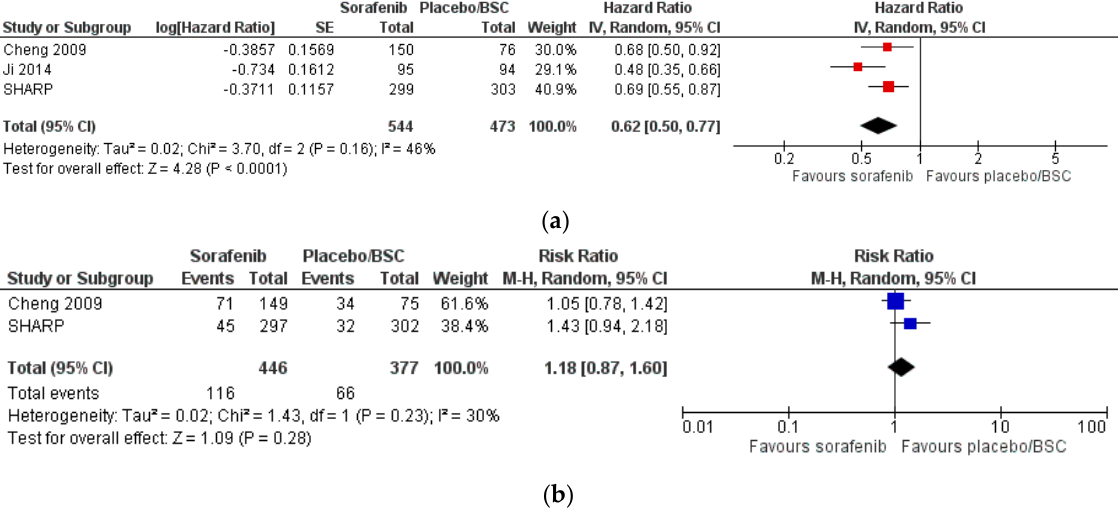
Figure 4. Forest plots for the outcomes ‘overall survival’ ( a ) and ‘toxicity’ ( b ) for the comparison of SOTs versus placebo/UPSC as first-line therapy in patients with advanced HCC. SOTs versus placebo/UPSC as first-line therapy in patients with advanced